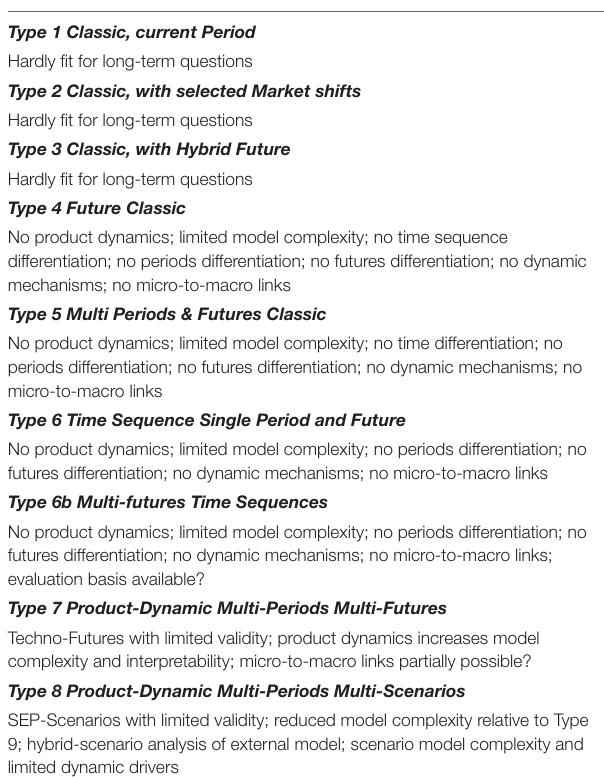
TABLE 4 | Main constraints on validity per life-cycle model type summarized for long-term